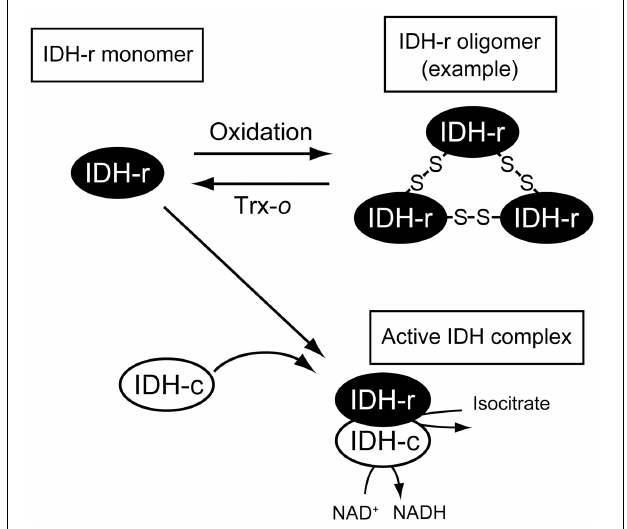
FIGURE 5 | Possible scheme of IDH redox regulation. IDH-r forms oligomer mediated by intermolecular disulfide bonds upon oxidation. Oxidized IDH-r can be reduced back to the monomer by Trx- o , which is essential for forming functional IDH complex (see the main text for